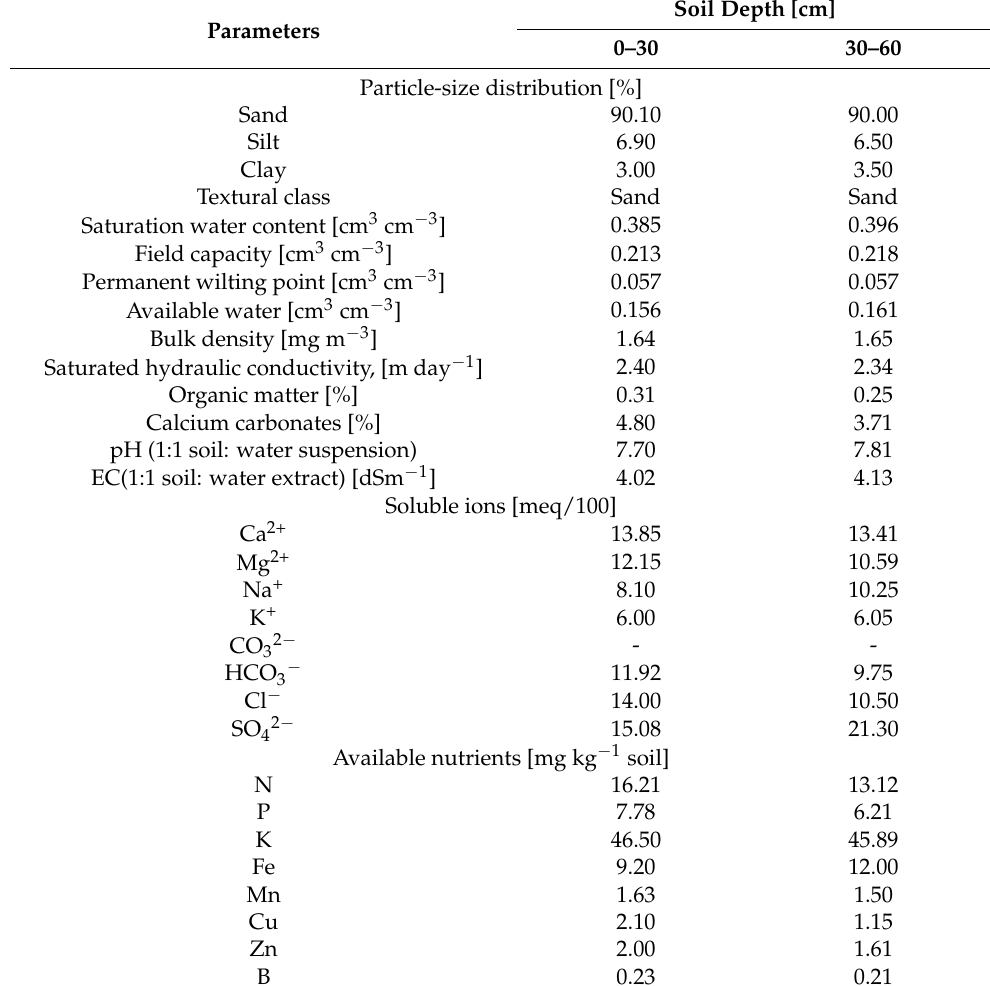
Table 1. Initial soil chemical analysis of the experimental site before treatment application.